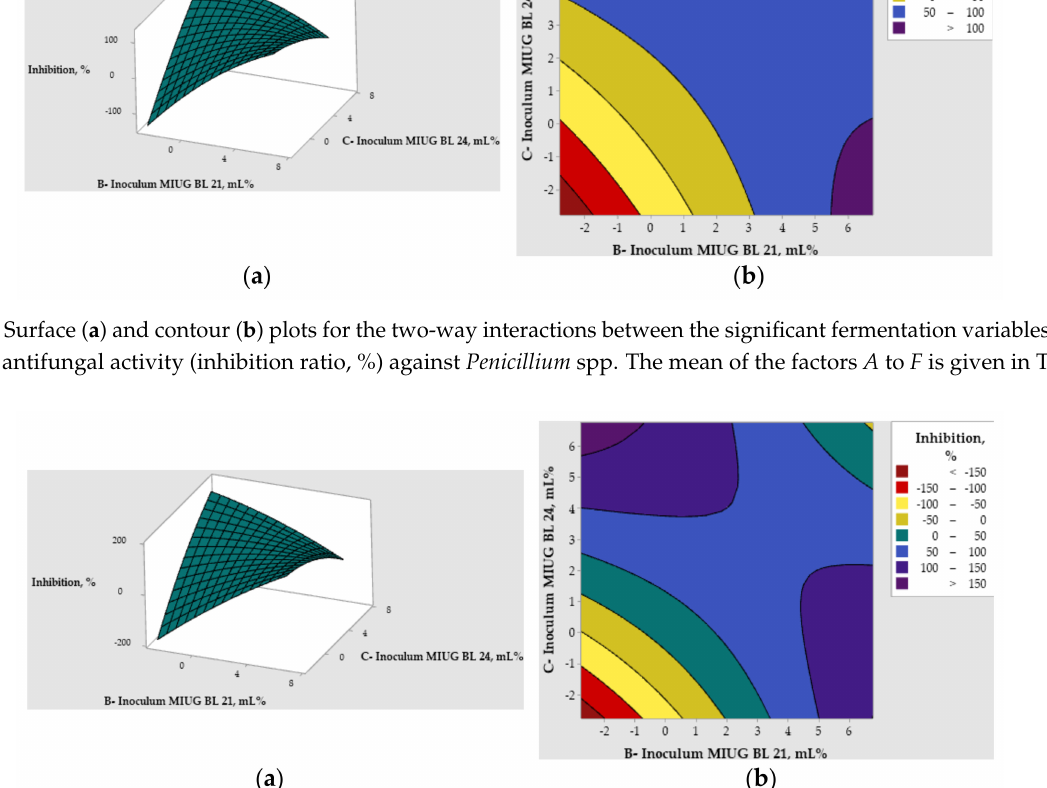
I , % = − 202.000 + 0.163 A + 16.400 B + 22.600 C − 3.290 D + 7.550 E + 2.061 F − 0.800 B 2 − 1.390 C 2